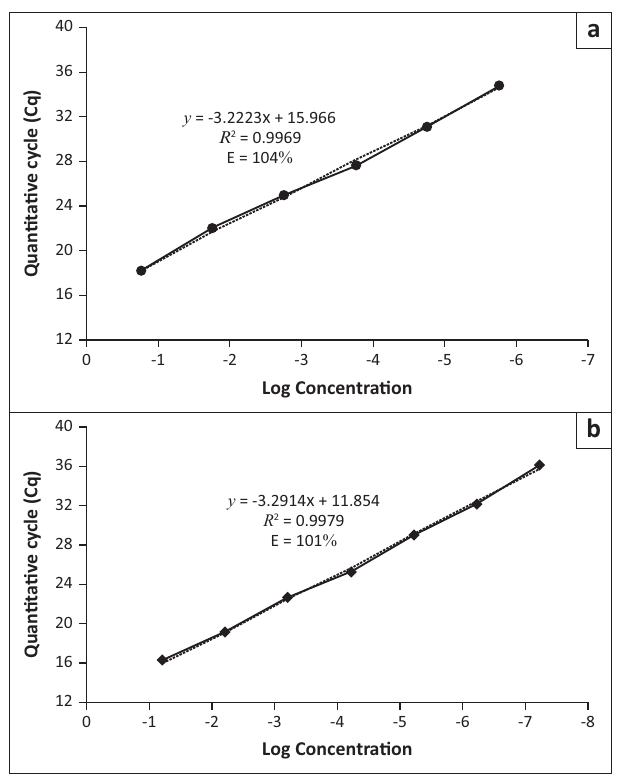
FIGURE 3: Detection of 10-fold serial dilutions of plasmid DNA by the duplex quantitative polymerase chain reaction assay. (a) Anaplasma marginale